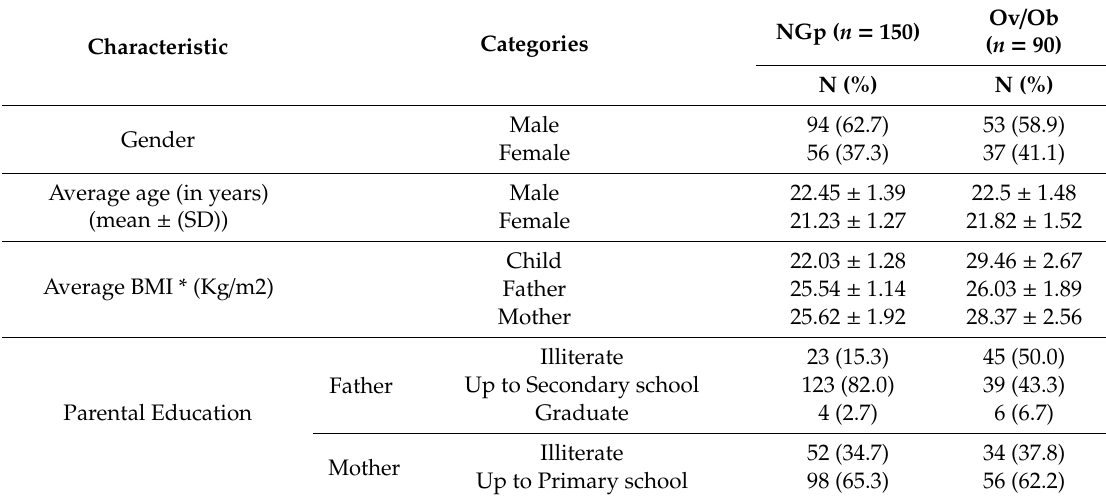
Table 1. Sociodemographic comparison between study groups (Normal weight (N Gp) and Overweight / Obese (Ov / Ob